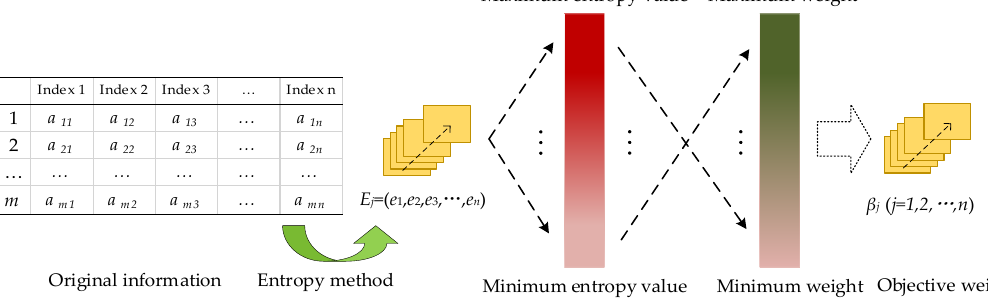
Figure 5. Schematic diagram of obtaining objective weight based on an entropy weight ( EW ) method.